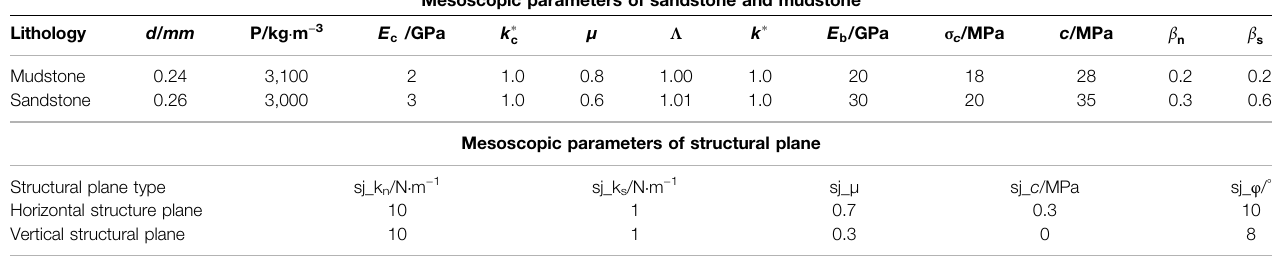
TABLE 3 | Mesoscopic